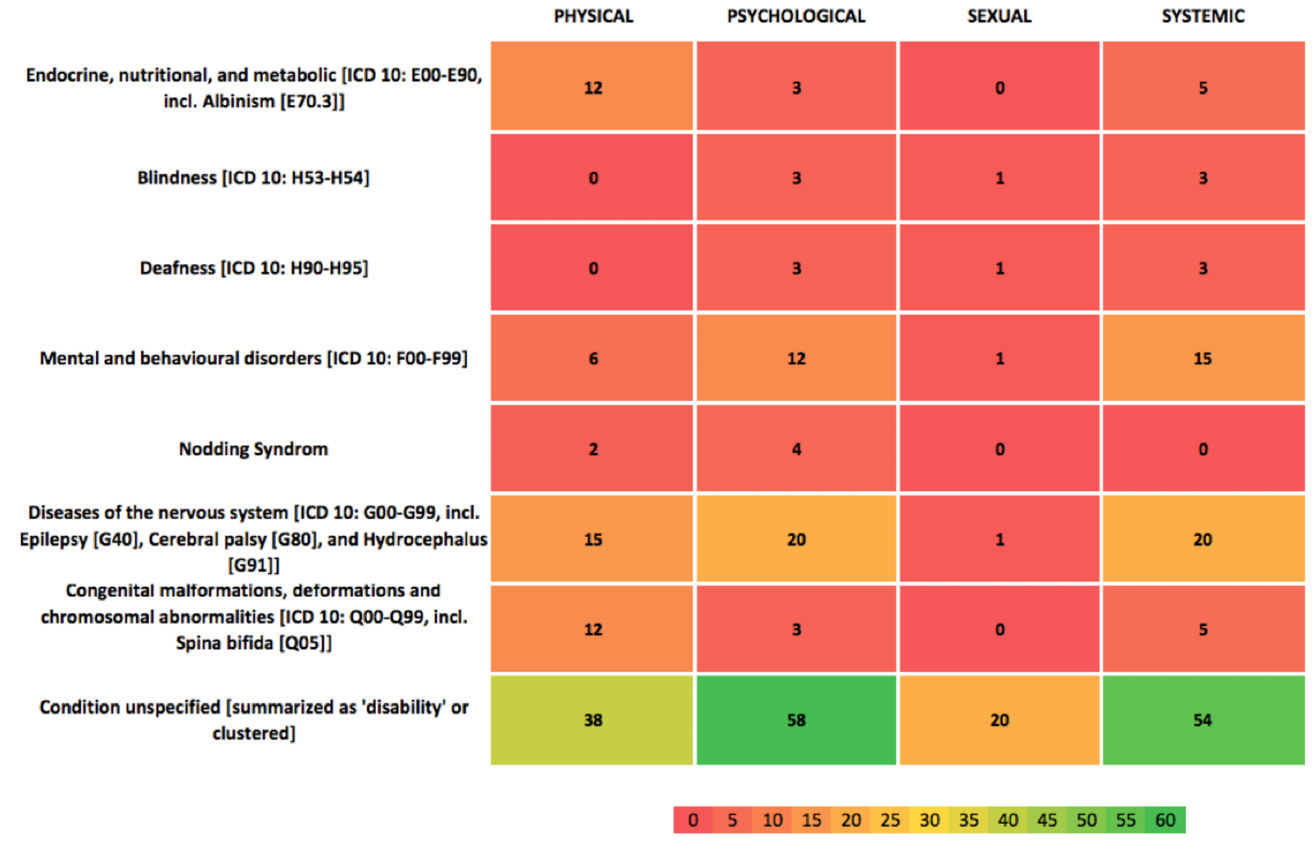
Fig 4. Heatmapwith colours indicating percentage of